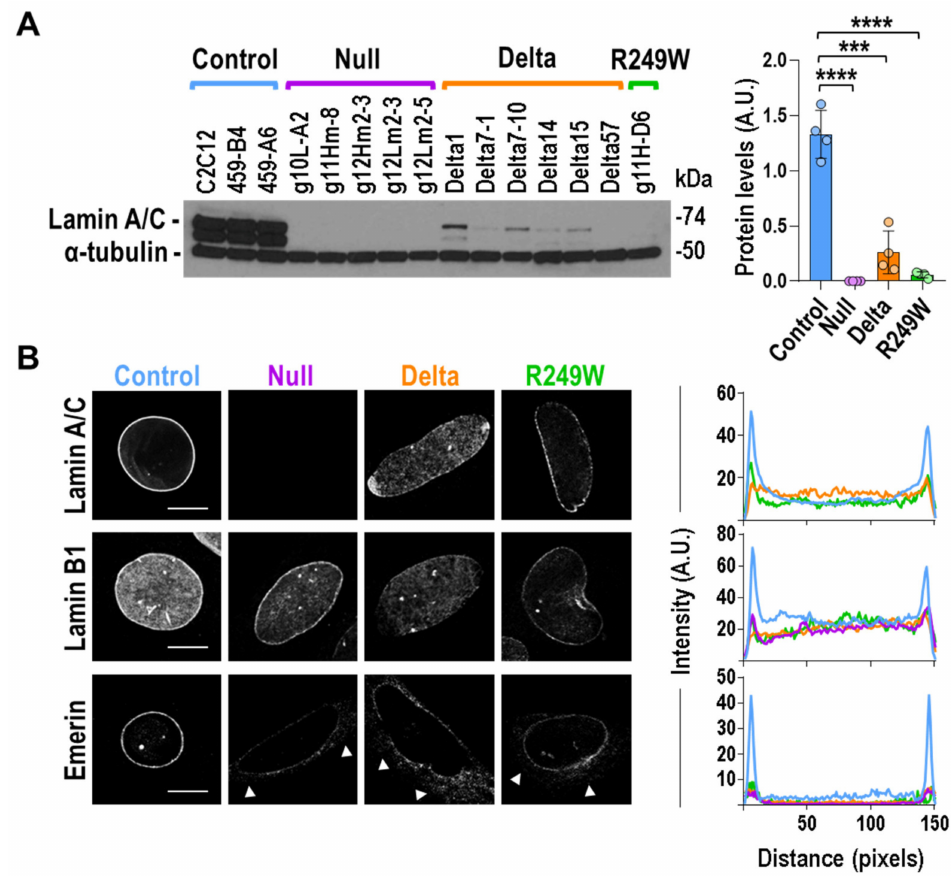
Figure 2. Components of the nuclear lamin were abnormally distributed in Lmna exon 4 mutant myoblasts. ( A ) Lamin A and C levels were reduced in Lmna exon 4 mutants. Quantification of Lamin A and C protein levels. Left pictures show one of the three independent biological replicates analyzed. The other replicates are included in Figure S5. Quantification of Lamin A / C signal in the three independent analyses, by mutant type, is shown on the right. Bars are mean ± SEM. Two-tailed, unpaired Student’s t -test: **** p < 0.0001, *** p = 0.003, n = 4. ( B ) Mouse myoblasts were immunostained for Lamin A / C, Lamin B1, and Emerin. Representative single confocal images from nuclei are shown for each Lmna group. Extra-nuclear signal was observed for Emerin in null, delta, and R249W mutants (arrows). Scale bar = 8 µ m. Right plots show average fluorescence intensity across nuclei by mutant type (control (blue): three clones; null (purple): five clones; delta (orange): six clones; R249W (green): one clone; n = 5 nuclei per clone). Peaks at both ends of the plot represent peripheral